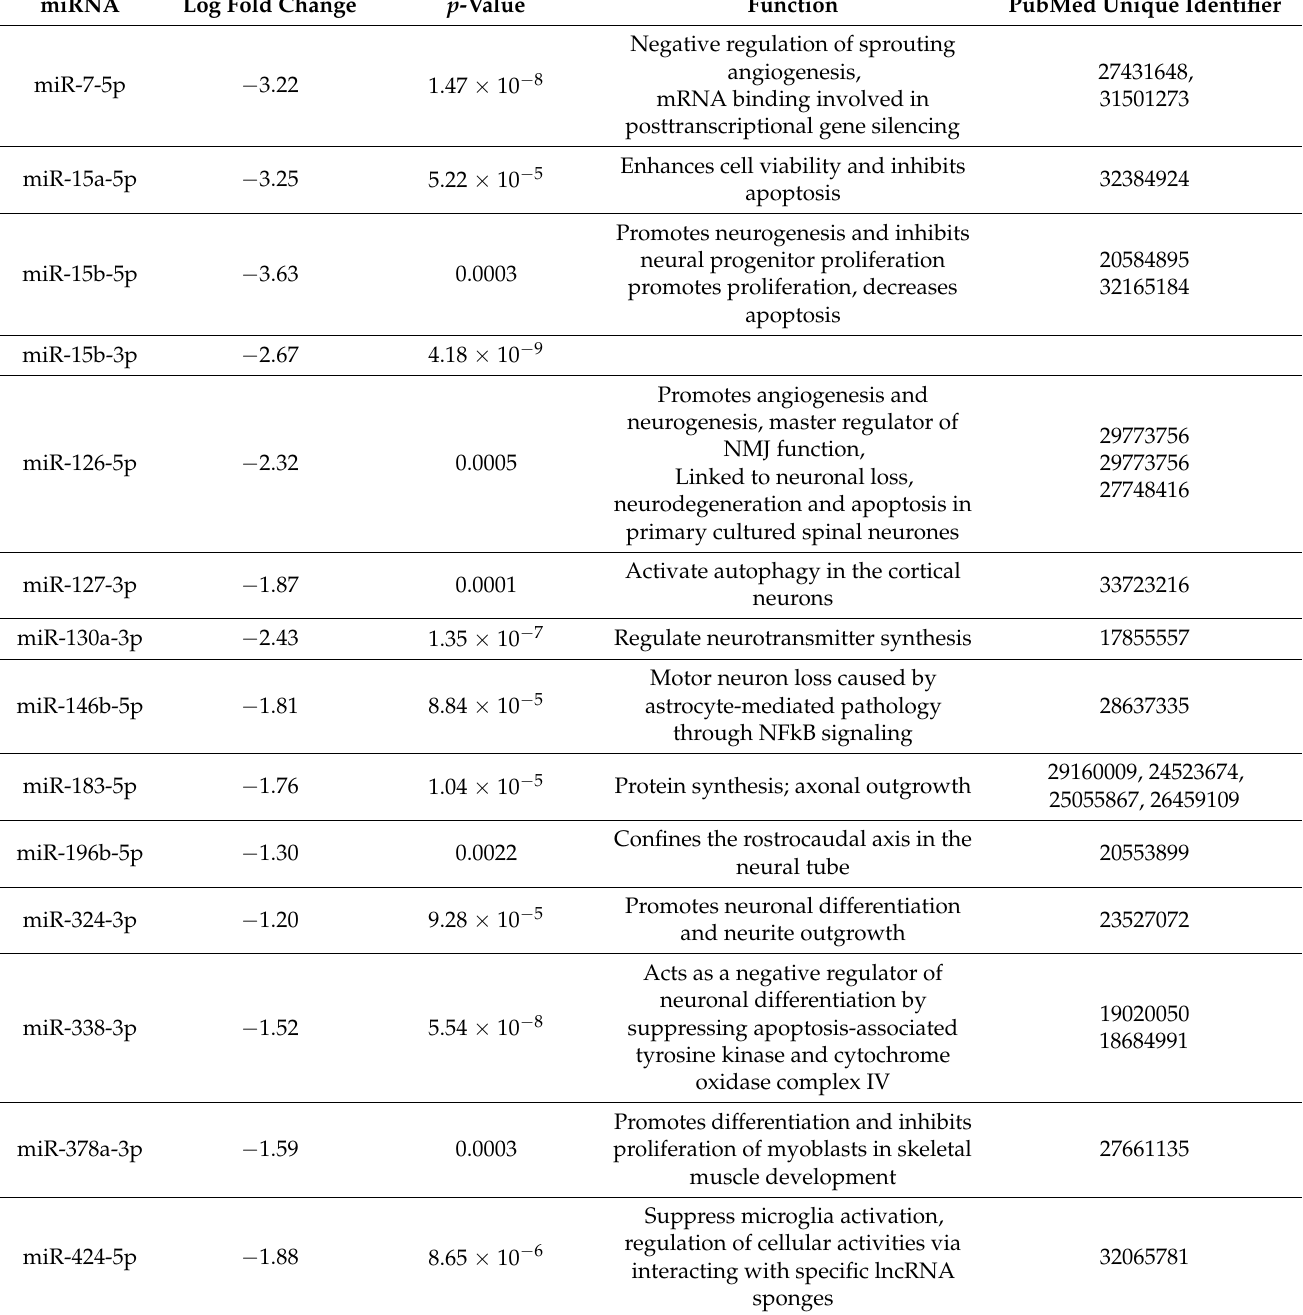
Table 2. Main functions of the differentially expressed miRNAs in SMA with nusinersen